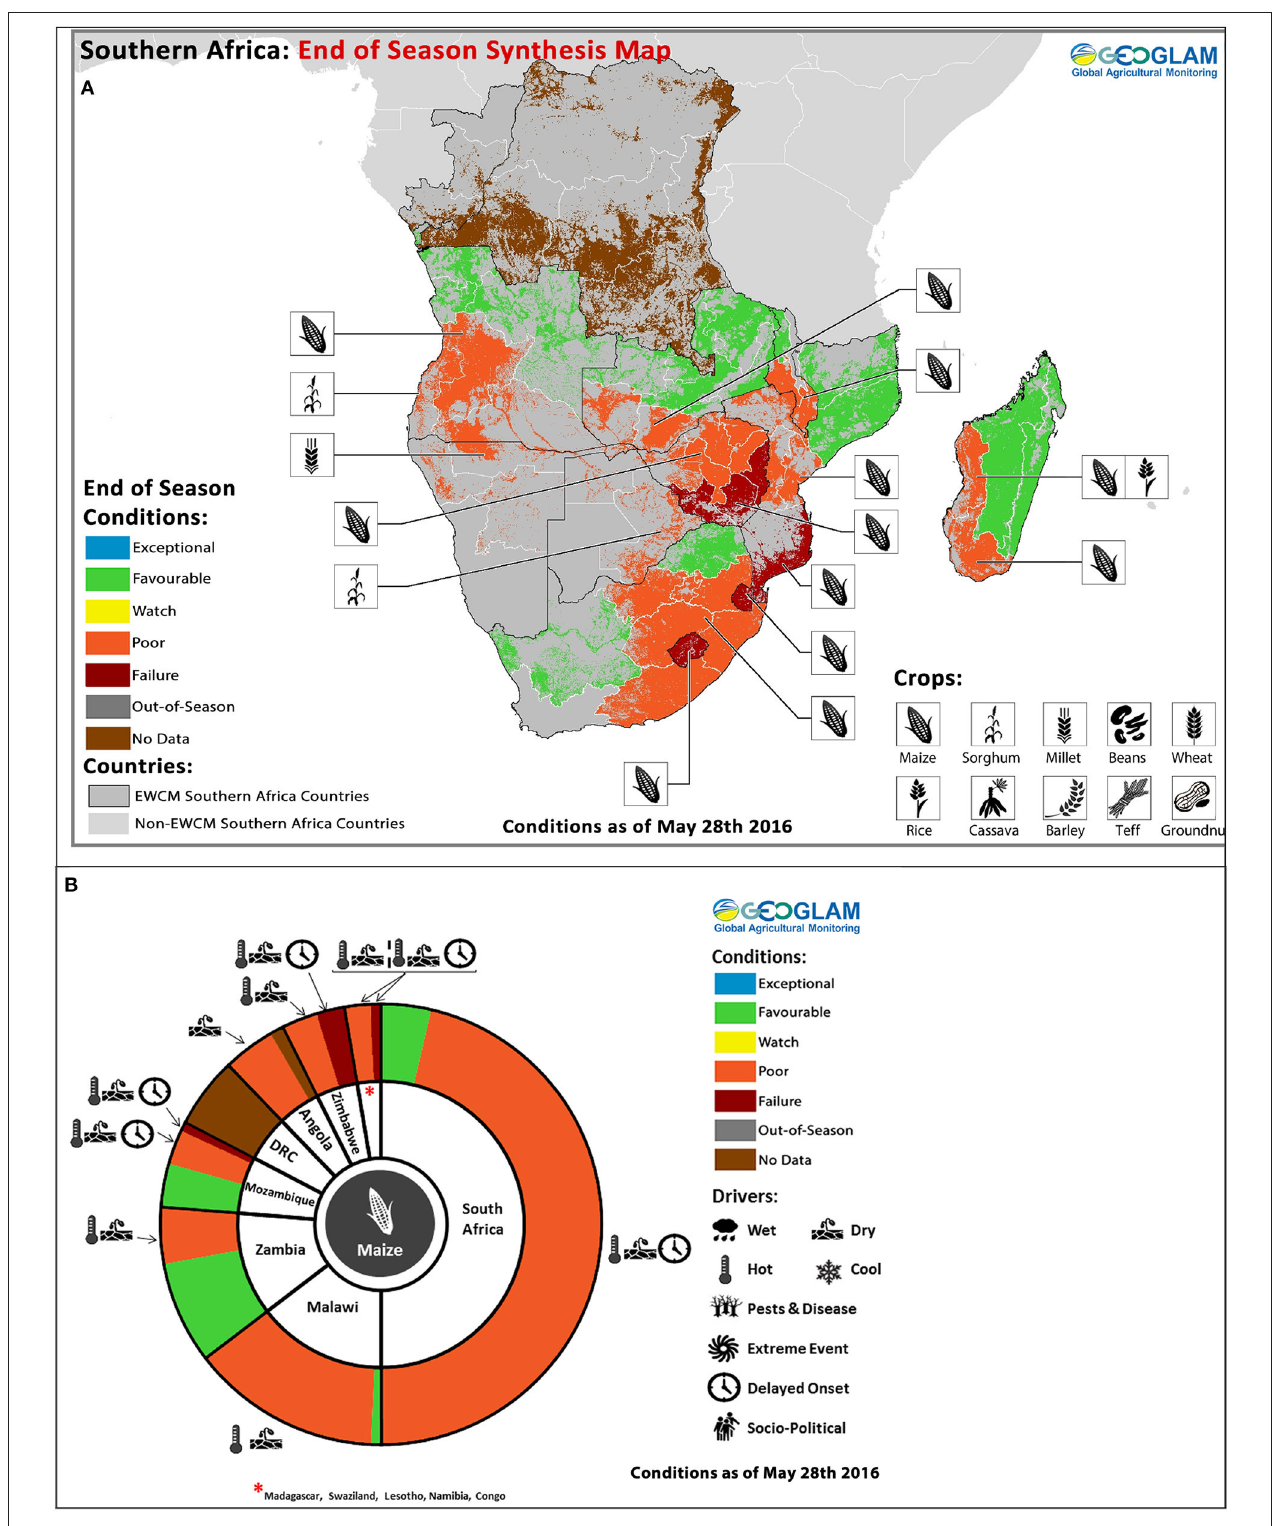
FIGURE 3 | (A) CM4EW synthesis map for Southern Africa, May 2016. CM4EW reports contain the same information as CM4AMIS, and additionally include a “failure” condition when production is expected to be > 25% below average, as well as additional drivers: delayed onset of rainy season, pests and disease, and socio-political factors. (B) Pie charts show conditions of crops, e.g., May 2016 maize, by share of national production.